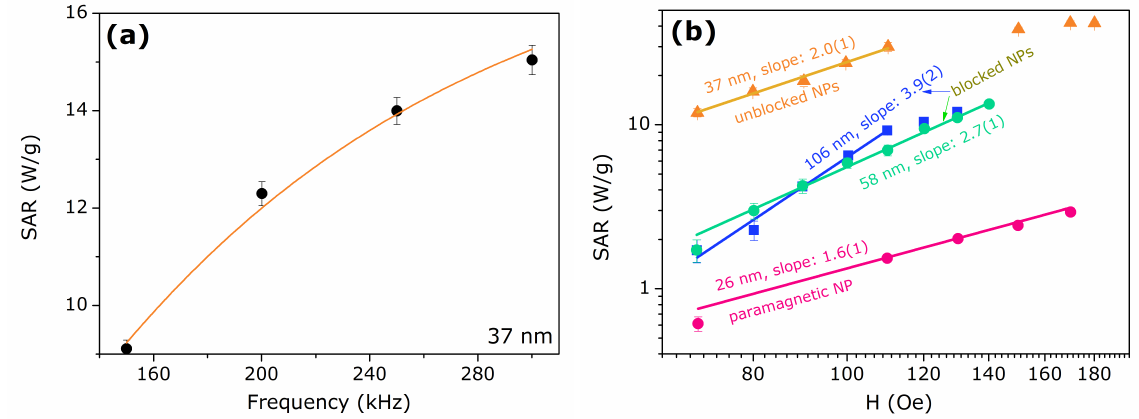
Figure 7. Specific Absorption Rate—SAR as a function of ( a ) frequency (sample with mean diameter size of 37 nm) and ( b ) magnetic field (all samples prepared). Solid lines represent the theoretical model (Equation